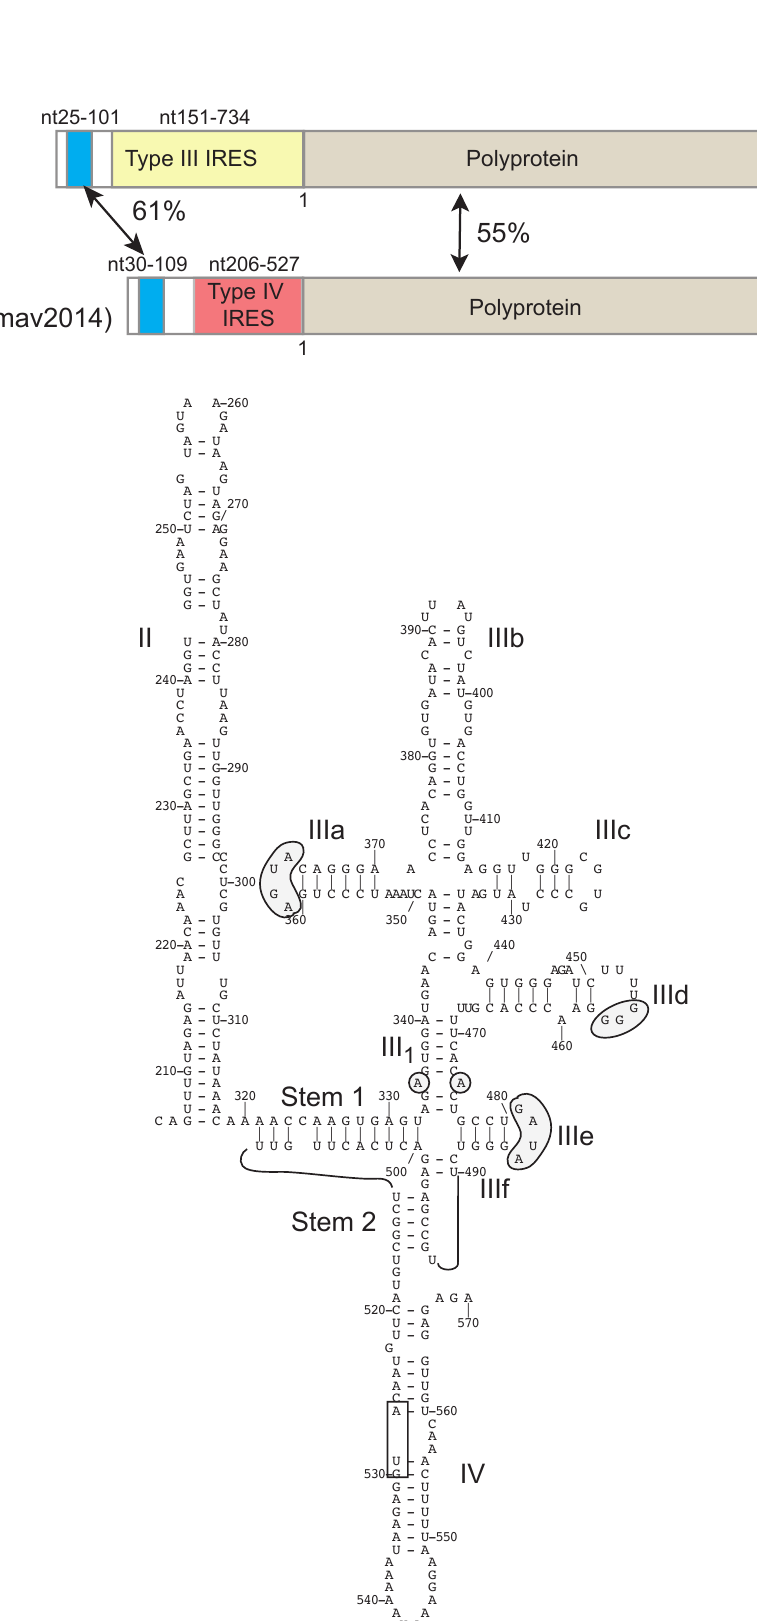
Figure 3. A type IV IRES in the genome of a member of the genus Hepatovirus . ( A ) Schematic representations of the 5 (cid:48) UTRs and adjacent coding region of hepatovirus A isolate HM175 (NCBI ref. seq. NC_001489.1) [147] and of hepatovirus C isolate SMG18520Minmav2014 (NCBI ref. seq. NC_038313.1) [131]. The 5 (cid:48) UTRs